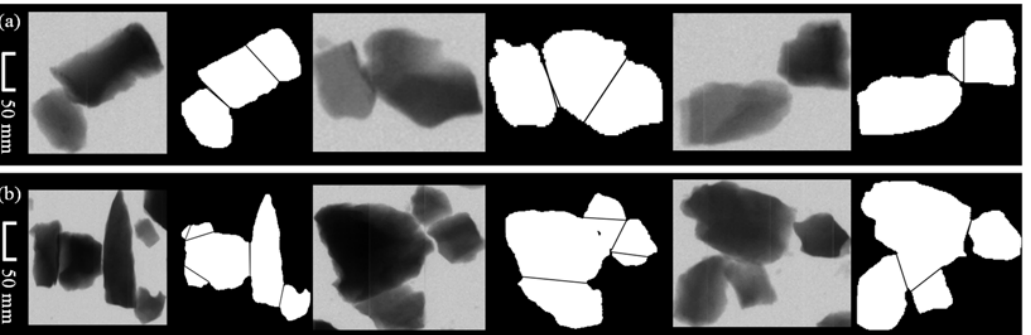
Figure 18. Error segmentation target: ( a ) Too many pits are detected, resulting in over-segmentation, ( b ) A pit detection error or a minimum distance finding error results in a segmentation error.